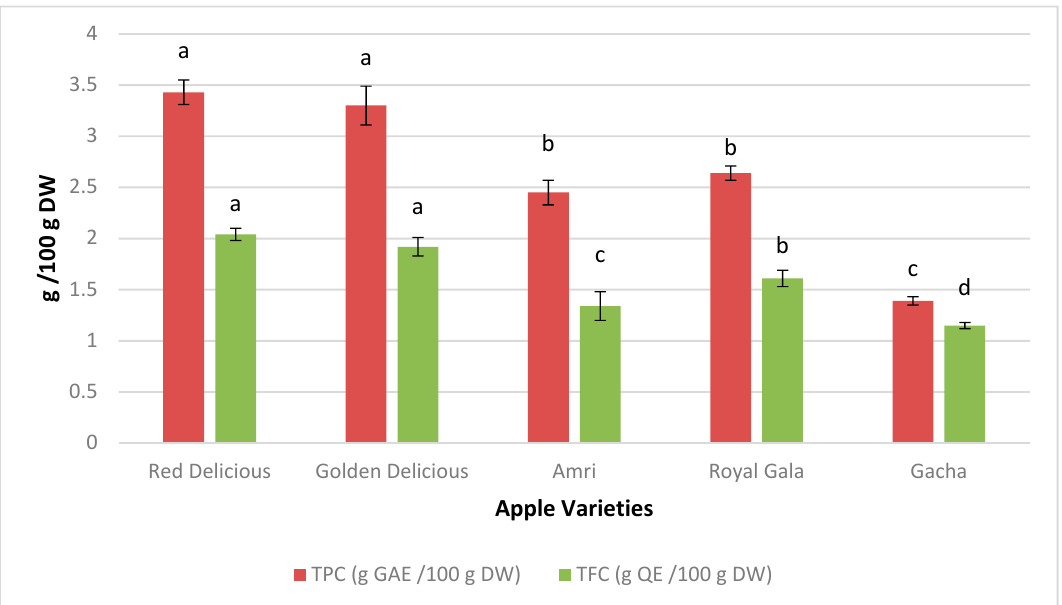
Figure 1. Total phenolic contents and total flavonoid contents of APPE of different apple varieties. Results presented by the average of the triplicates followed ± standard deviation. Different letters in a column of same color denote significant differences ( p ≤ 0.05). APPE: Apple peel polyphenol extract; GAE: gallic acid equivalents; QE: quercetin equivalents.